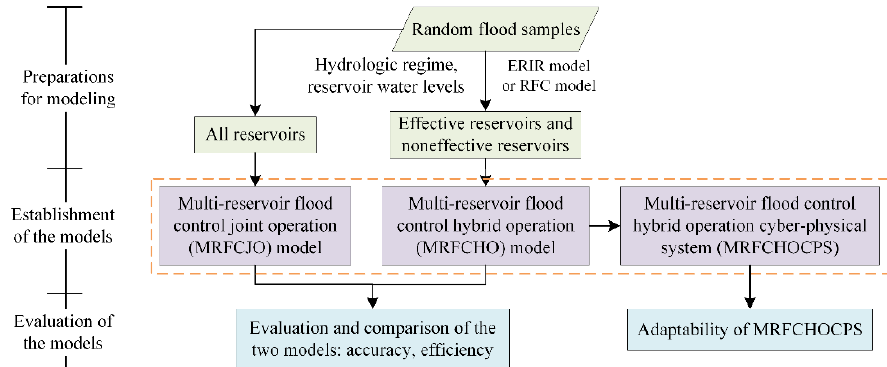
Figure 1. Flowchart of the proposed dynamic self-adaptive modeling